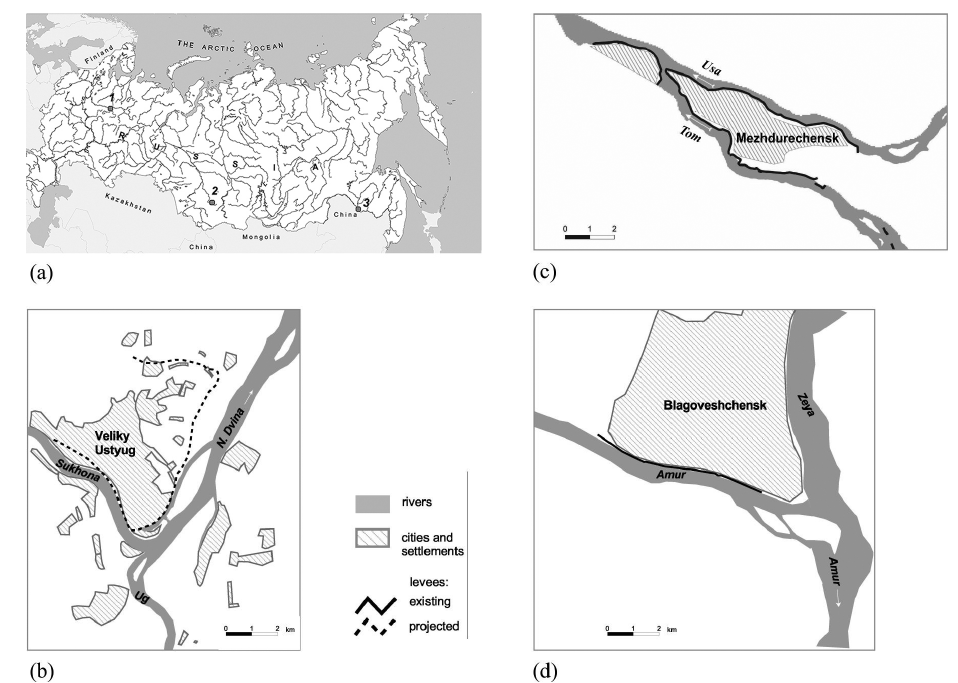
Figure 1. Case study areas: (a) overall location, (b) Veliky Ustug at the Northern Dvina, (c) Mezdurechensk at the Tom river, (d) Blagovesh- ensk at the Amur river.